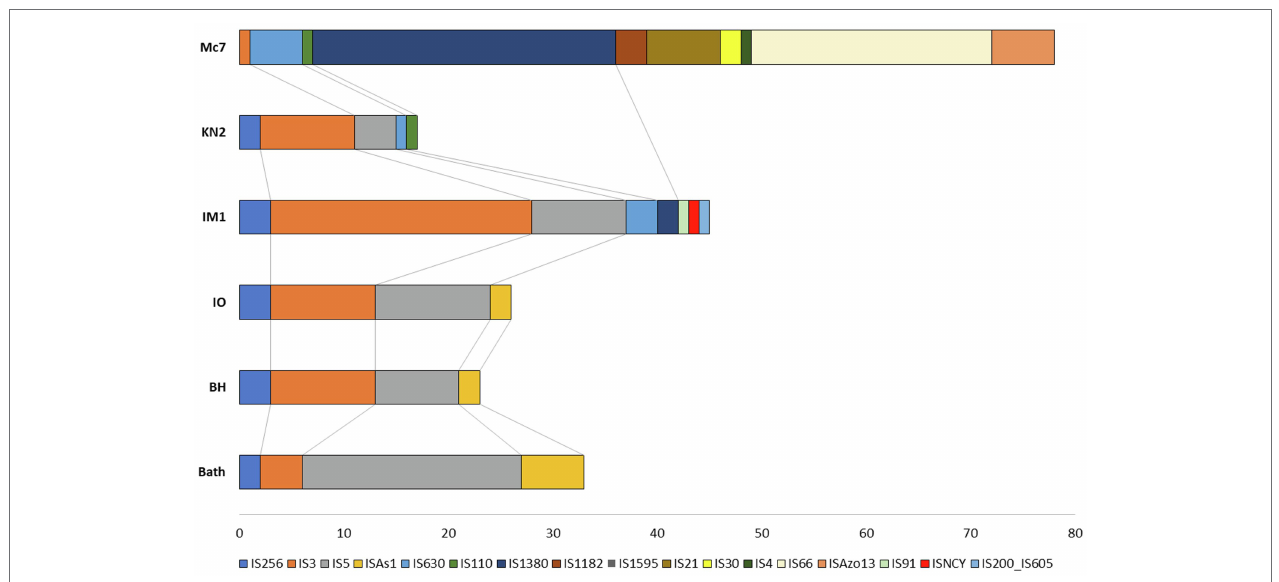
FIGURE 9 | Distribution of insertion sequences (IS) element families in Methylococcus